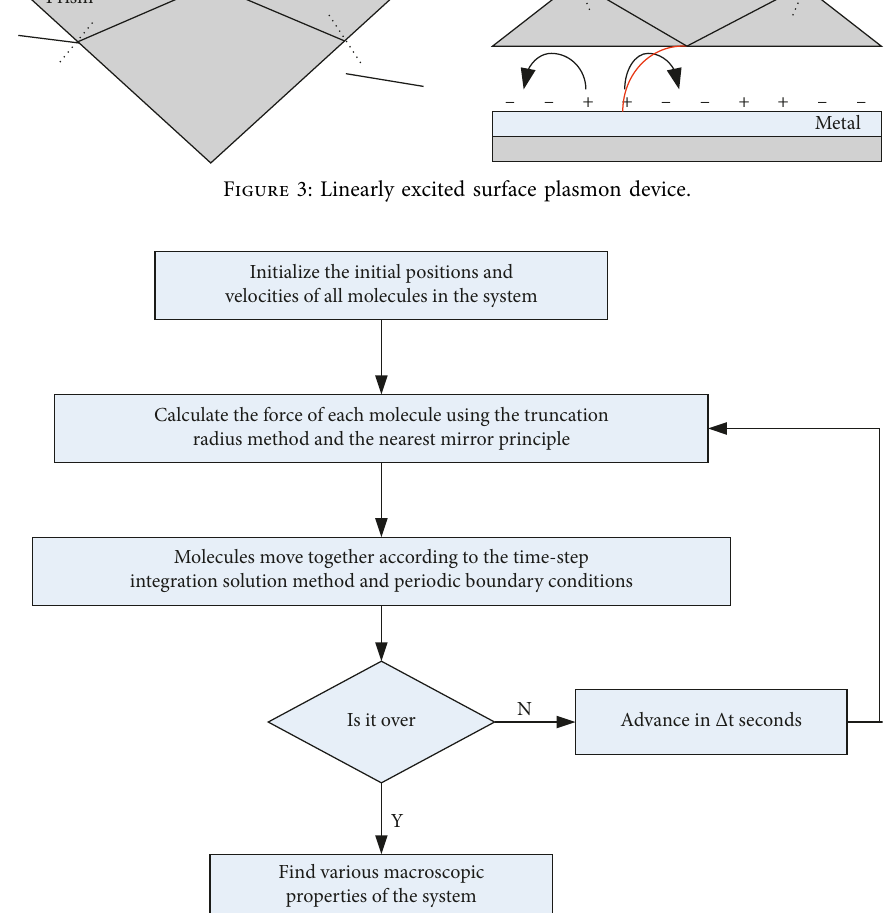
Figure 4: Flow chart of the molecular dynamics simulation method.